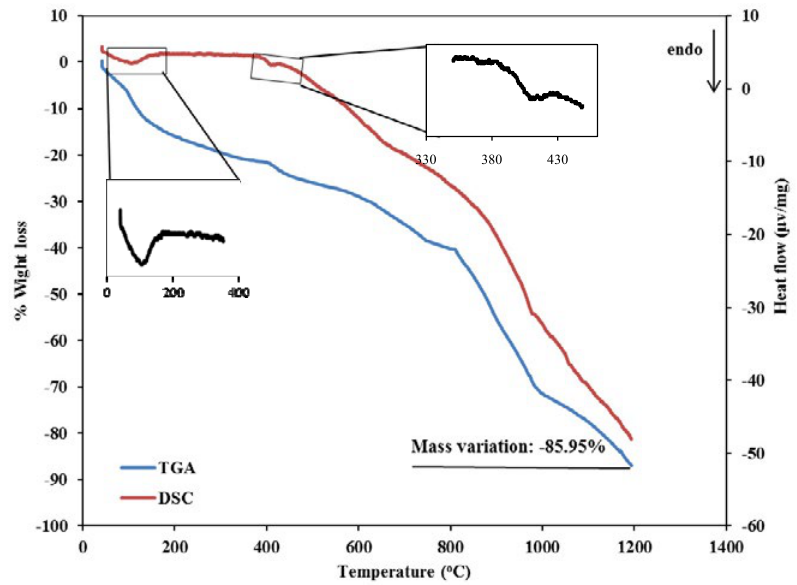
Fig. 9: TGA- DSC curves of the sample synthesized at 98 o C, 72 Fig. 9. TGA- DSC curves of the sample synthesized at 98 o C, 72 h.